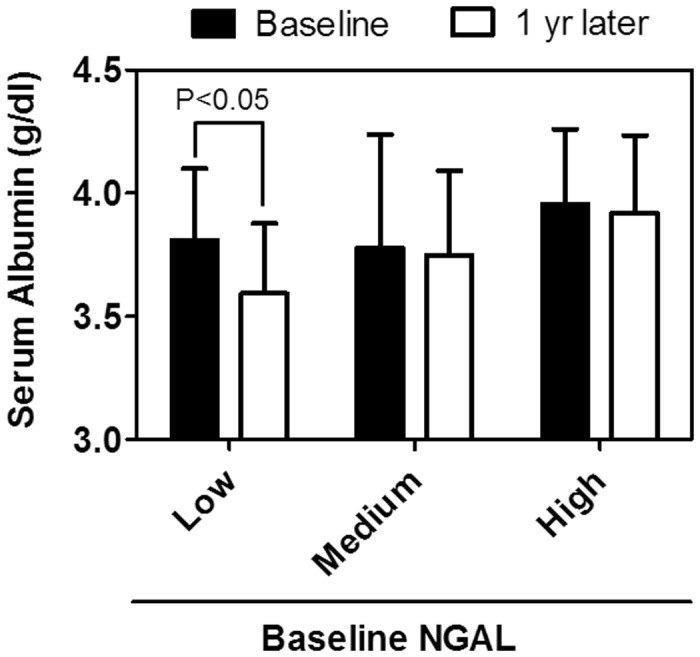
Change in serum albumin levels in a year among 3 groups assigned by baseline serum NGAL tertiles.Comparison was carried out by paired t-test. N = 87.